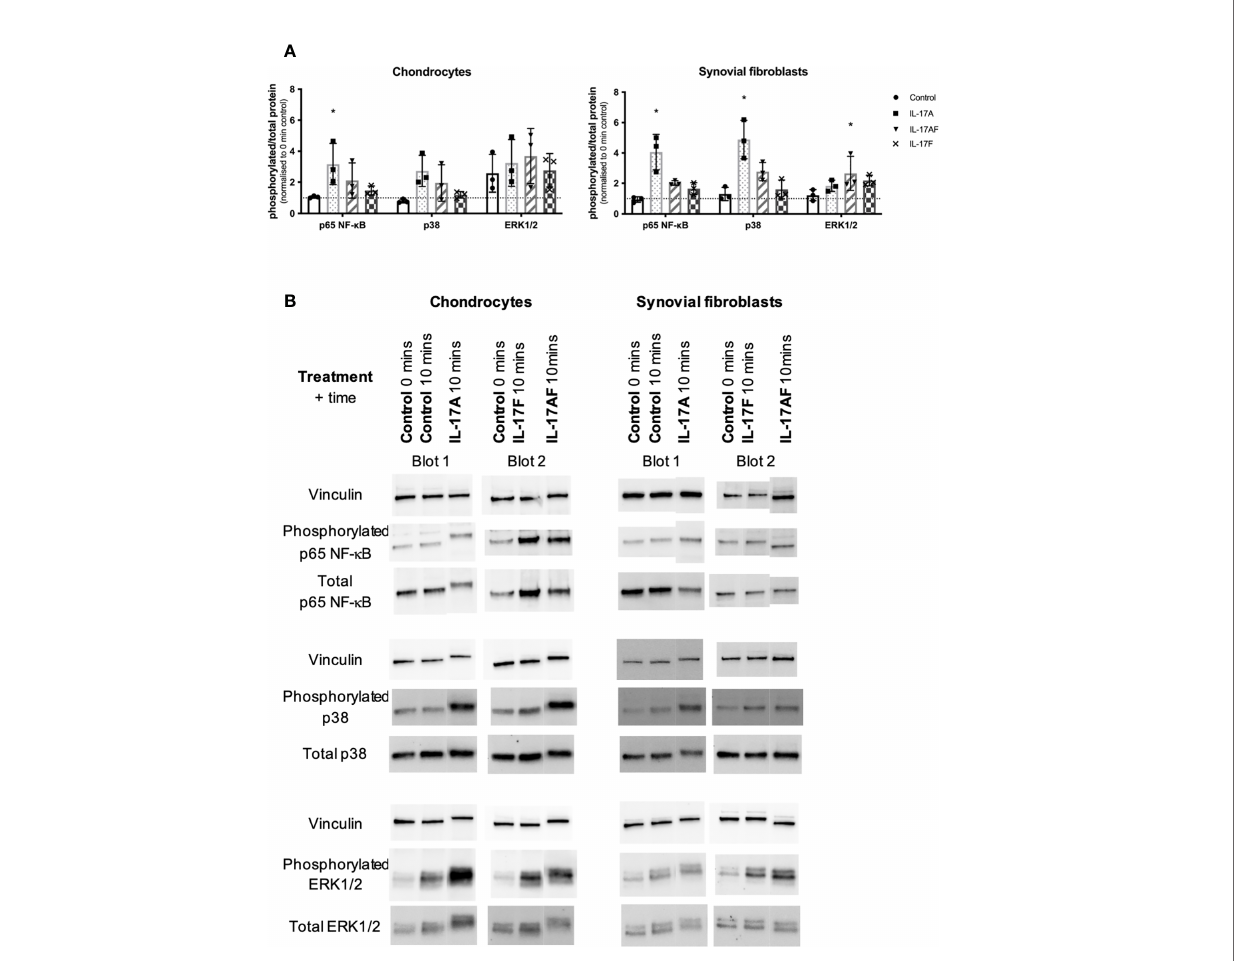
FIGURE 5 | Activation of p65 NF-s – B, p38 MAP kinase, and ERK1/2 (p44/p42 MAP kinases) in chondrocytes and synovial fi broblasts by IL-17A, IL-17AF, and IL-17F (all 10 ng/ml) after 10 minutes stimulation. (A) Relative ratio of phosphorylated protein over total protein compared to baseline control (0 mins). Friedman test for each intracellular protein with Dunn ’ s multiple comparisons test. Mean ± SD. N=3. *p < 0.05. (B) Representative western blots for vinculin (loading control), phosphorylated, and total protein of each intracellular signalling protein. Full-size, uncropped western blots, including additional time points, can be found in Supplementary Figure 4